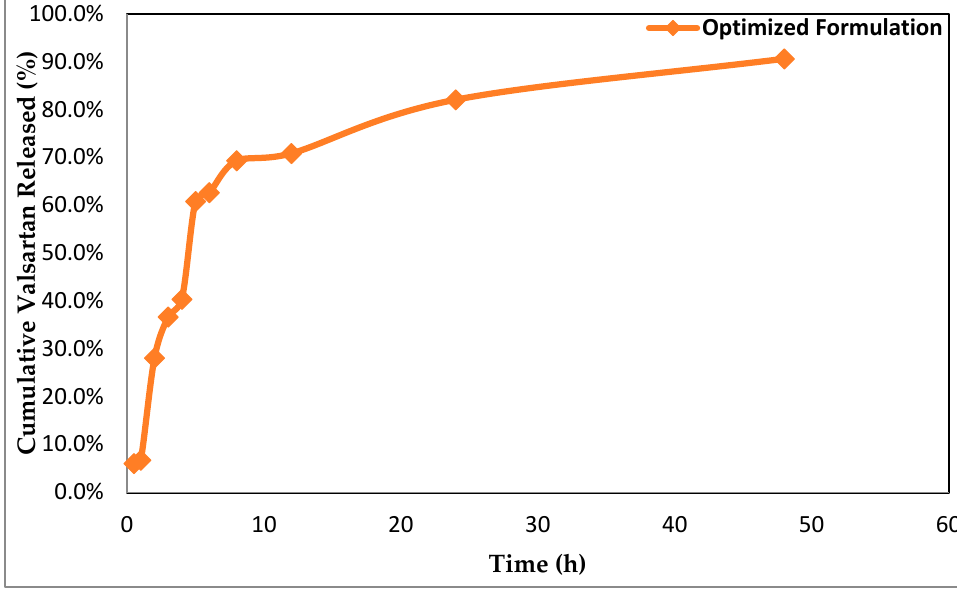
Figure 5. In vitro release of VLT from ethosome formulation (optimized formula).